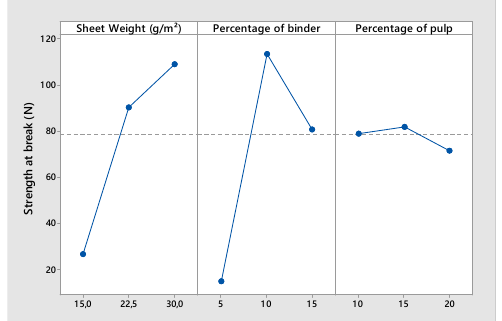
Figure 5. Main effects plot for strength at break.